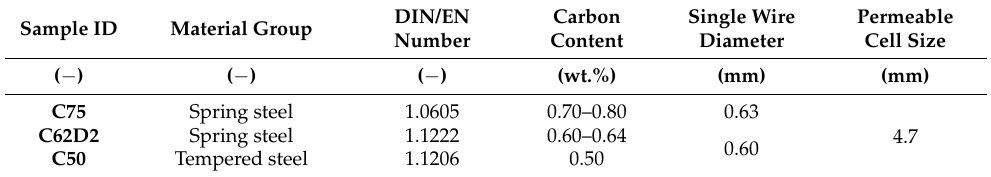
Table 1. Material composition and dimensional specifications of the 3D TWS strucwire ® .